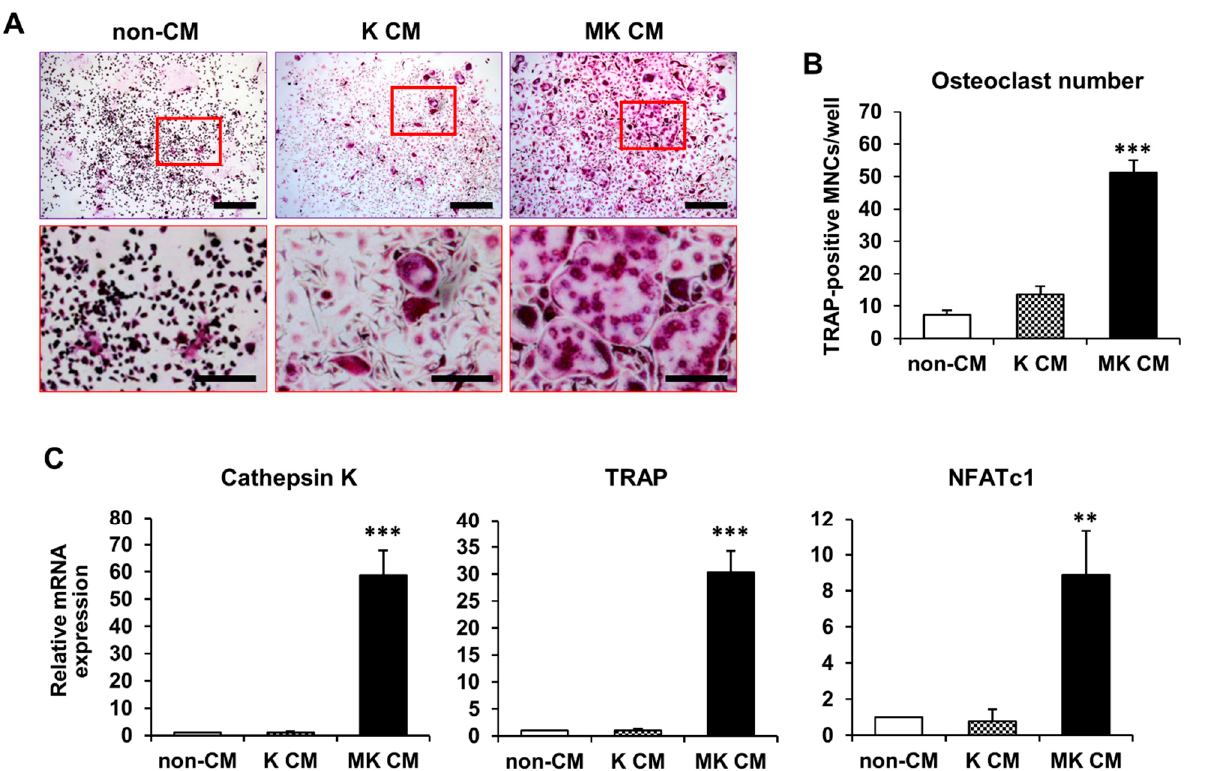
Figure 1. Effect of MK CM on the differentiation of bone marrow-derived macrophages (BMMs) into mature osteoclast-like cells. ( A ) BMMs were cultured in osteoclast differentiation medium containing M-CSF (20 ng/mL) and RANKL (20 ng/mL) in the presence of K562-cultured CM (K CM) or MK CM. The non-CM control group was cultured in osteoclast differentiation medium mixed with 50% of RPMI1640. The cells were stained with TRAP to examine osteoclast differentiation. Scale bar, 500 μ m. High-magnifications of the red rectangles in the upper panels are shown in the lower panels. Scale bar, 200 μ m. ( B ) Number of TRAP-positive multinucleated cells (MNCs) with three or more nuclei was counted. ***, p < 0.001 versus non-CM. ( C ) mRNA expression of cathepsin K, TRAP, and NFATc1 was evaluated by qPCR during osteoclast differentiation. The relative mRNA expression level was plotted against gene expression levels in non-CM, which were set to 1.0. The results are representative of three independent experiments. **, p < 0.01 and ***, p < 0.001 versus non-CM.